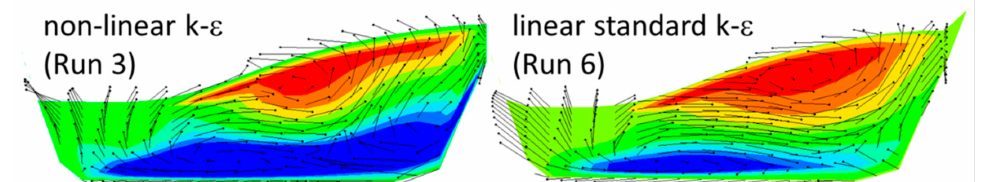
Figure 11. Cross-sectional velocity vectors and color contour of streamwise vorticity along the A-A’ section with different turbulence models.